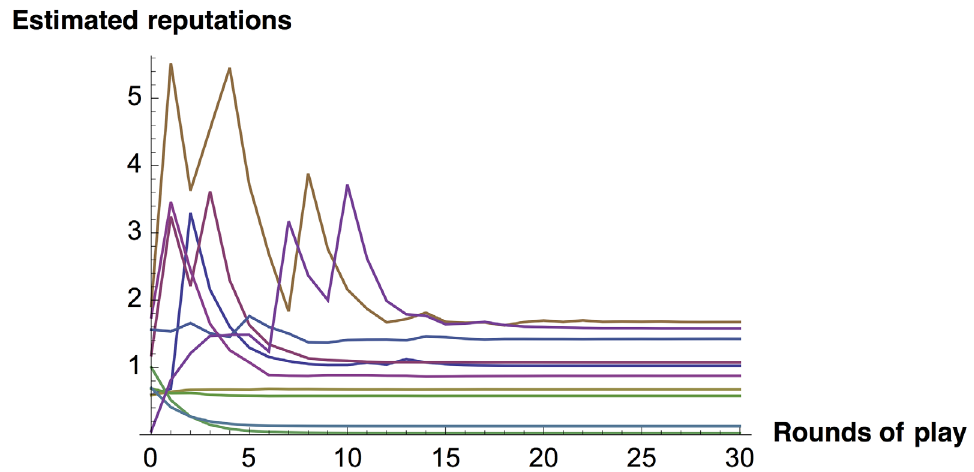
Fig 2. Reaching equilibrium with Almost Balanced Reciprocity. In a group of 40 players, each player j produces benefits for a random 5 players i in each round, following b B and beginning in round 1 using random private estimates of s i . For each j , every other player k calculates a revised s j of her own, after observing a random 3 of j ’ s 5 random acts of kindness, by plugging the 3 b ij ’ s and her 3 unrevised s i ’ s into the implicit function given by Condition 4. For each j , player k then averages her revised and unrevised s j ’ s to generate new s j ’ s that will determine how much she helps a random 5 players in the next round. Chart shows a typical result for a random player ’ s private estimates of s j ’ s for 10 other random players j : her s j ’ s converge on α j ’ s. (Generalized Reciprocity gives similar